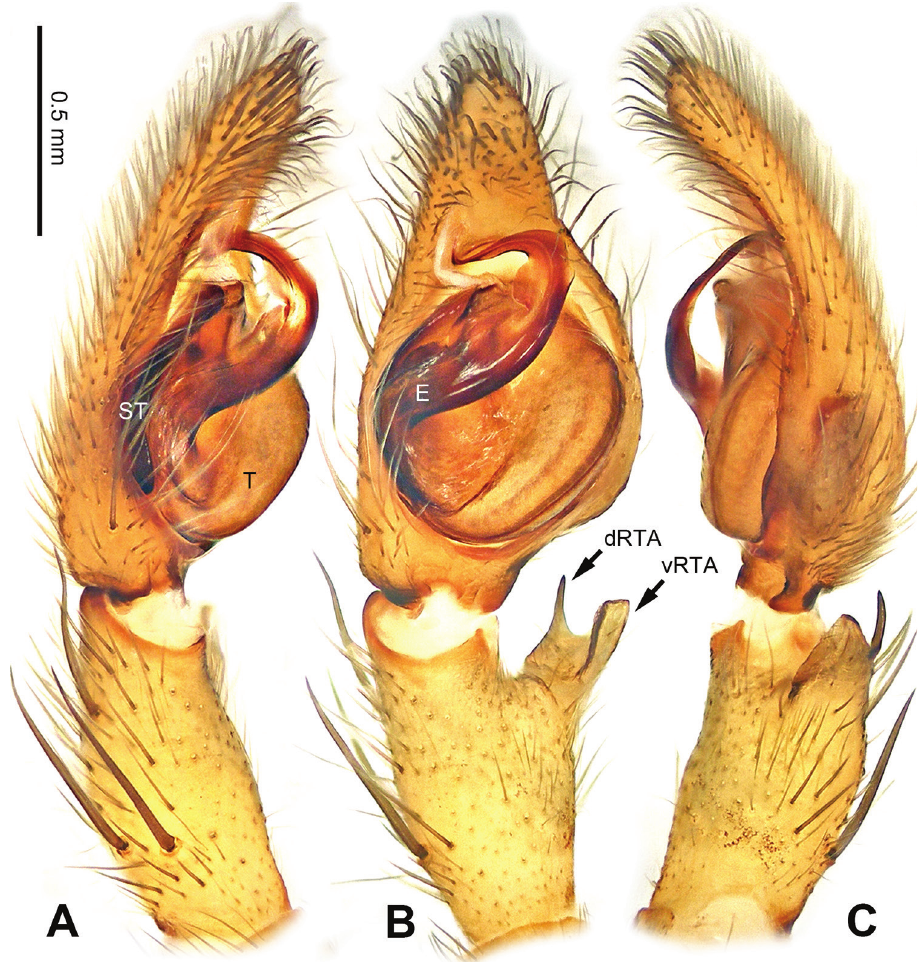
Figure 10. Pseudopoda gexiao Zhao & Li, sp. n., left palp of male holotype. A Prolateral view B Ventral view C Retrolateral view. Scale bar equal for A, B, C